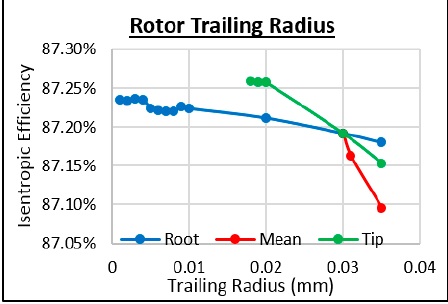
Figure 38. Study of the rotor trailing radius.